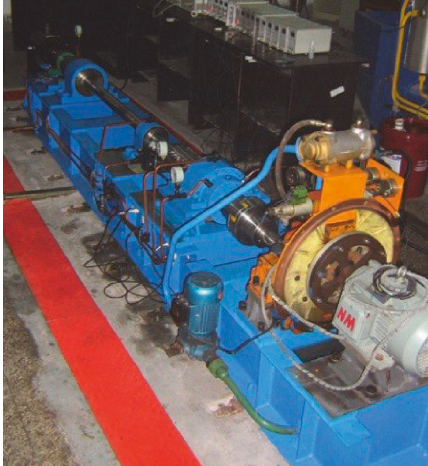
Figure 2: The experimental rig for marine propulsion shafting longitudinal vibration